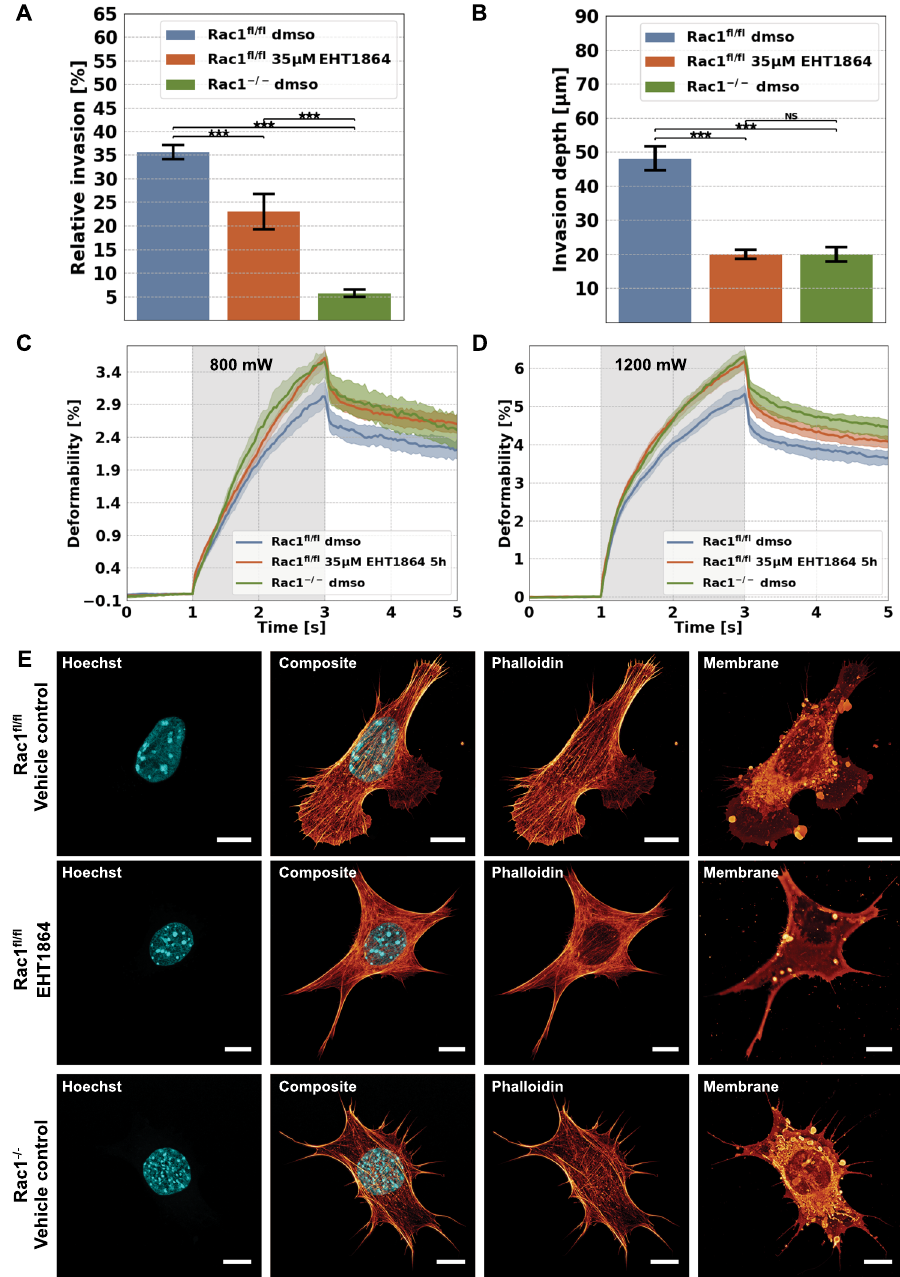
Figure 4. Effect of the Rac1 inhibitor EHT1864 (35 µ M) on cellular motility, cellular deformability and the morphology of Rac1 fl/fl and for comparison Rac1 − / − cells are shown. ( A ) Percentage of invasive cells and ( B ) invasion depths of Rac1 fl/fl and Rac1 − / − cells. For each condition, between 500 and 1600 cells were analyzed. ( C , D ) Long axis deformation of Rac1 fl/fl cells (blue) in the presence or absence of treatment with EHT1864 at low “stretch” laser powers of 800 mW ( C ) and high “stretch” laser powers of 1200 mW ( D ), and for comparison the long axis deformation of Rac1 − / − cells (green). As control serves each cell type incubated with the DMSO buffer, which has been used as a solvent for the drug. ( E ) Nuclear shape, actin cytoskeletal structure, composite of nuclear shape, actin cytoskeleton and membrane shape of a representative Rac1 fl/fl cell in the absence (top row images) or presence of EHT1864 (intermediate row images) and a representative Rac1 − / − cell (bottom row images). All scale bars are 10 µ m. *** p < 0.001and NS = not